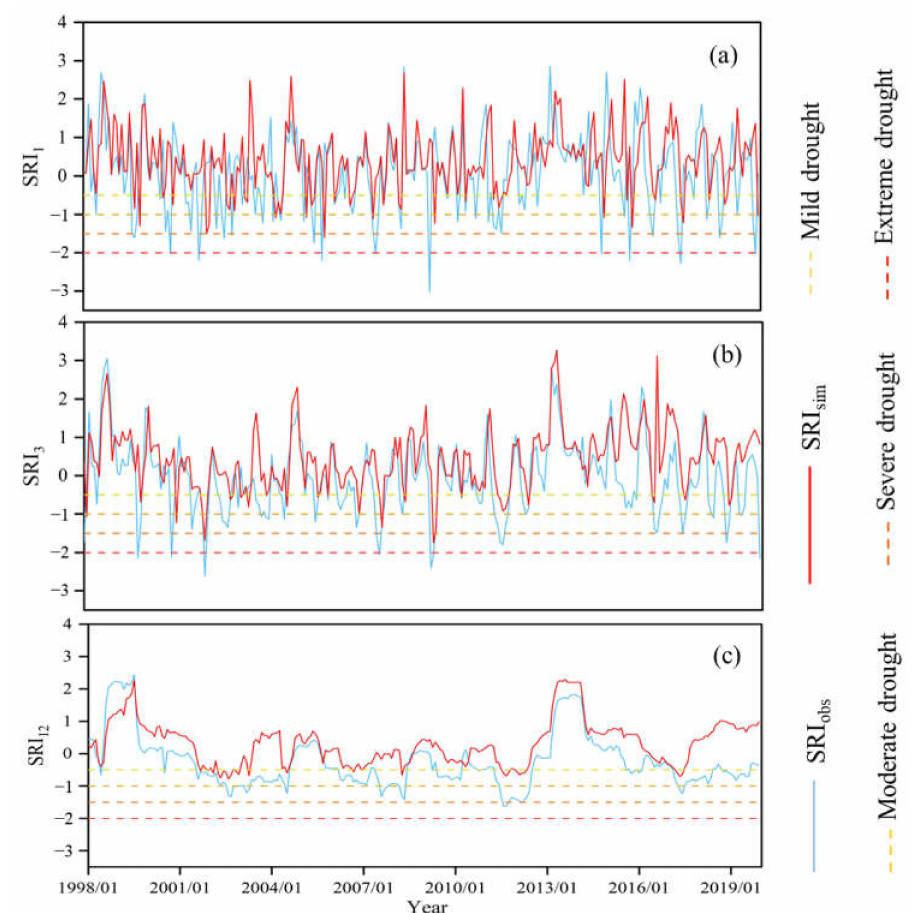
Figure 6. Variation of SRI based on the observed and simulated runoff during the impact period. ( a ) SRI 1 ; ( b ) SRI 3 ; ( c ) SRI 12